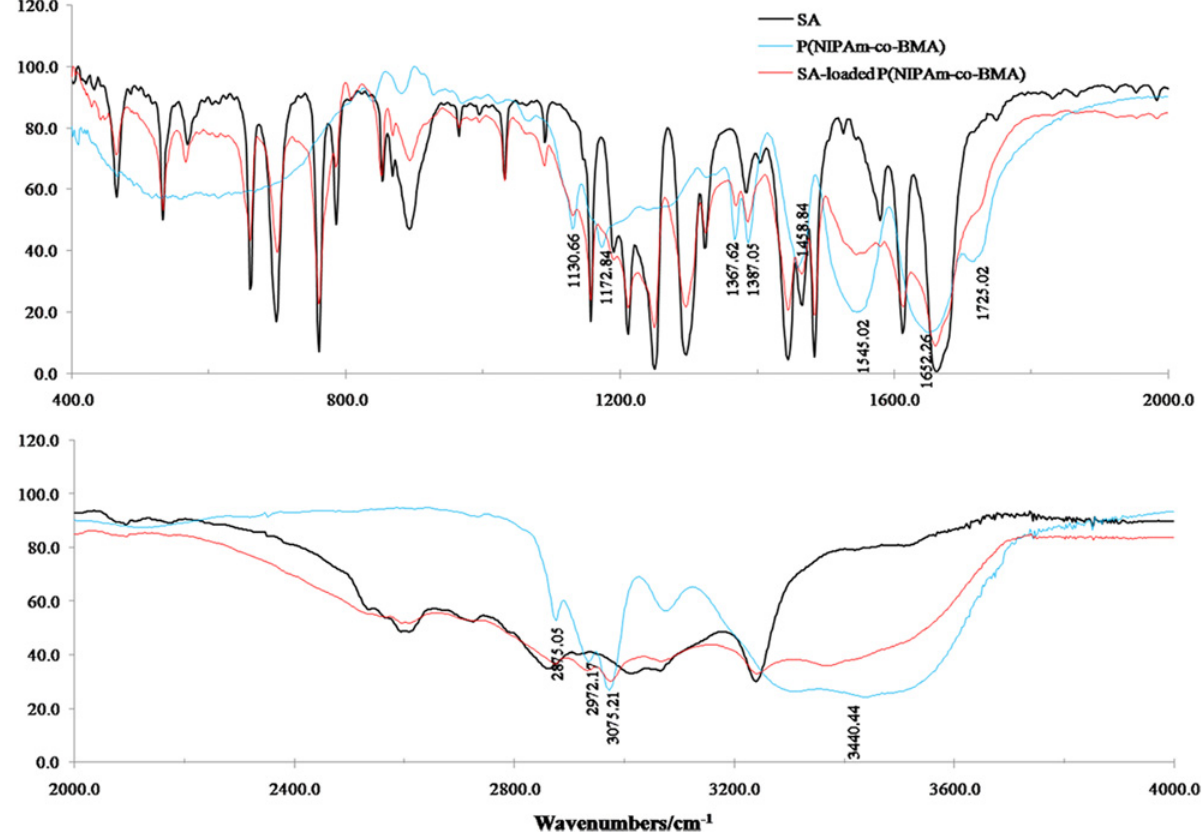
Fig 4. The fourier transform infrared spectroscopy (FTIR) spectrum of SA, the P(NIPAm- co -BMA) hydrogel and the SA-loaded P(NIPAm- co -BMA) hydrogel. P(NIPAm- co -BMA) is poly (N-isopropyl acrylamide- co -butylmethacrylate) and SA is salicylic acid; The SA-loaded P(NIPAm- co -BMA) hydrogel is the P(NIPAm- co -BMA) hydrogel loaded by SA through a solvent sorption method; The absorption peaks showed in the figure indicate special chemical bonds or functional groups. The top figure is the FTIR spectrum from 400 – 2000 cm -1 wavenumbers and the bottom figure is the FTIR spectrum from 2000 – 4000 cm -1